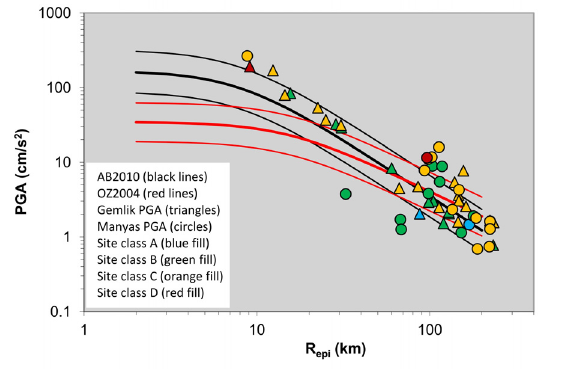
Figure 3. Attenuation of PGAs of Manyas and Gemlik earthquakes are compared with the empirical relations given by Akkar and Bom- mer [2010] (AB2010), and Ozbey et al. [2004] (OZ2004). The GMPEs (thick lines) and ±1 standard deviations (thin lines) are plotted for a =5.0 earthquake and stiff soil conditions. Color codes strike-slip M W are given in the graph